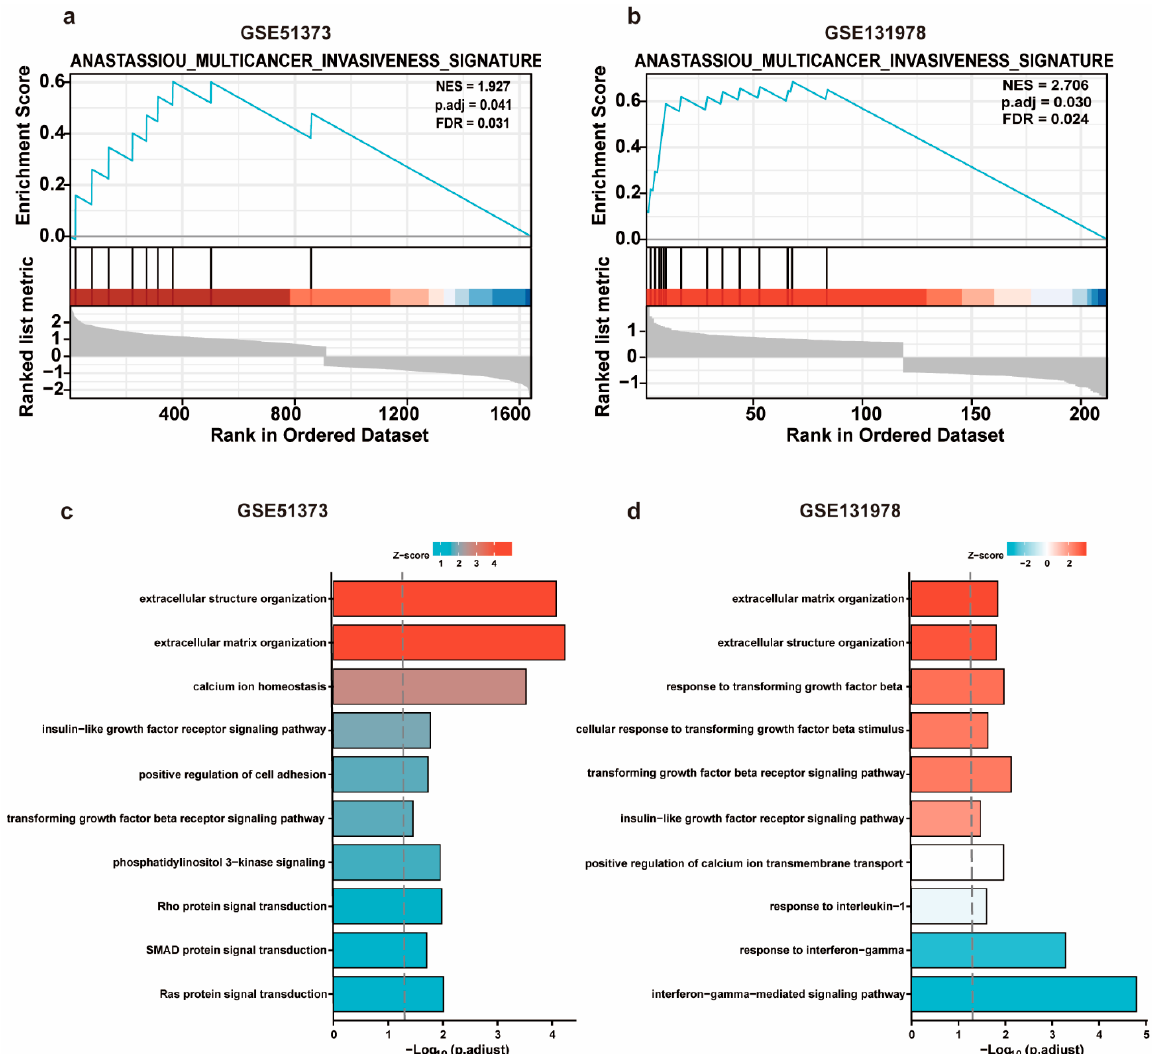
Figure 4. GSEA analysis and GO enrichment analyses of platinum-resistant-associated DEGs. ( a , b ) GSEA analysis of DEGs in GSE51373 and GSE131978. ( c , d ) GO (Biological Process) enrichment analyses of DEGs in GSE51373 and GSE131978. Only pathways of interest showing a p -value < 0.05 are presented.